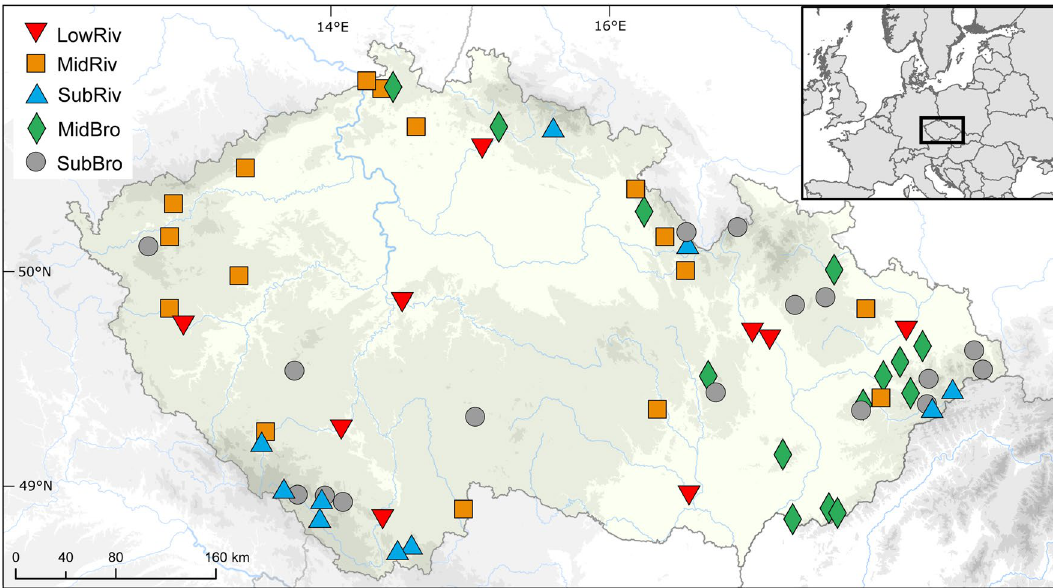
Figure 1. Locations of the sampling sites in the Czech Republic: low altitude rivers (LowRiv), mid-altitude rivers (MidRiv), submontane rivers (SubRiv), mid-altitude brooks (MidBro), and submontane brooks (SubBro). The map was created using Arcgis 8.3 program 59